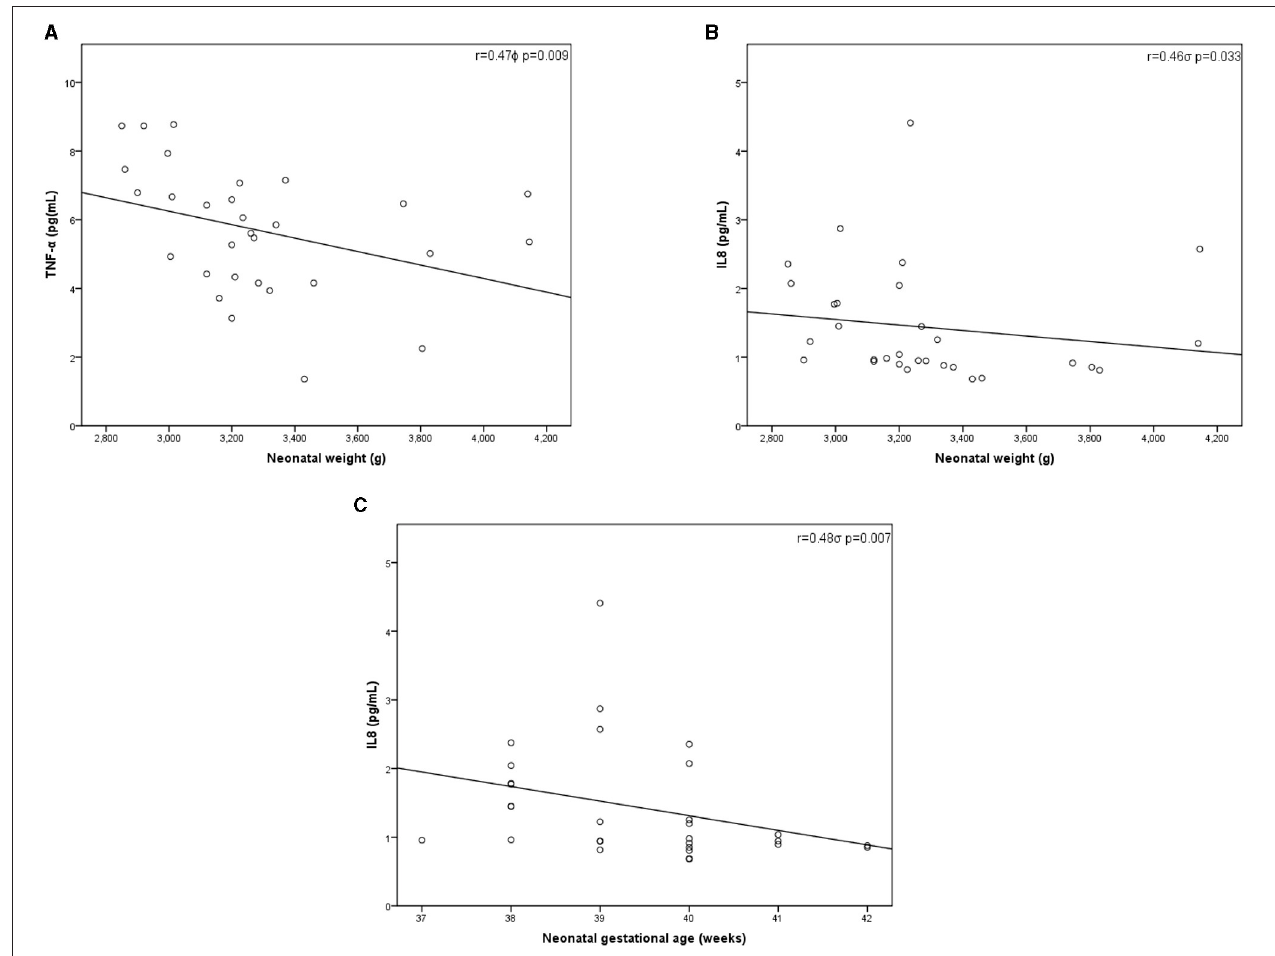
FIGURE 3 | Inflammatory cytokines levels and neonatal characteristics correlations. Pearson φ (TNF- α ) and Rho de Spearman σ (IL-8) correlations. (A) Correlation between TNF- α and neonatal weight φ ; (B) Correlation between IL-8 and neonatal weight σ ; (C) Correlation between IL-8 and neonatal gestational age σ . IL, Interleukin; p , p -value; r , Correlation coefficient; TNF- α , Tumor necrosis factor